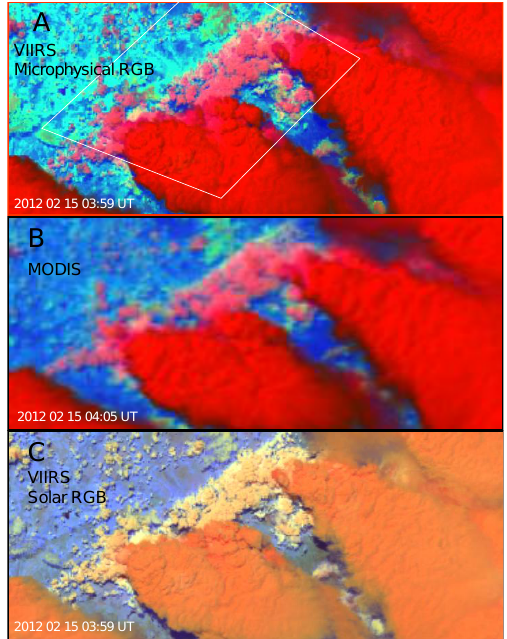
Fig. 19. Pristine deep convection, as seen by VIIRS (A) and MODIS (B) overpasses on 15 February 2012 over eastern Australia for an area of 155km × 109km centered at 26.13 ◦ S, 147.02 ◦ E. Panels (A) and (B) are shown with the microphysical RGB and panel (C) again shows VIIRS image with the solar